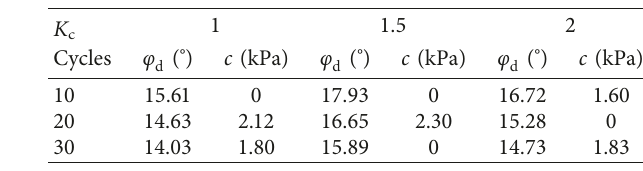
� 50kPa; (b) σ � 100kPa; (c) σ � 150kPa. 3c 3c 3c Table 3: Dynamic strength indexes of saturated sand under dif- ferent initial shear